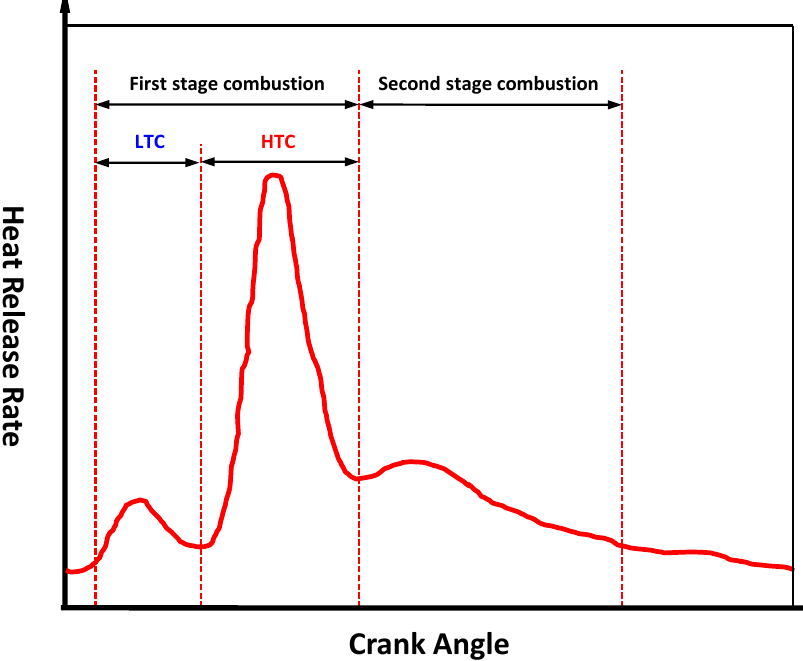
Figure7. RepresentativeheatreleasecharacteristicsofPCCIcombustion. L / HTC:low- / high-temperature Figure 7. Representative heat release characteristics of PCCI combustion. L/HTC: low-/high- temperature combustion.